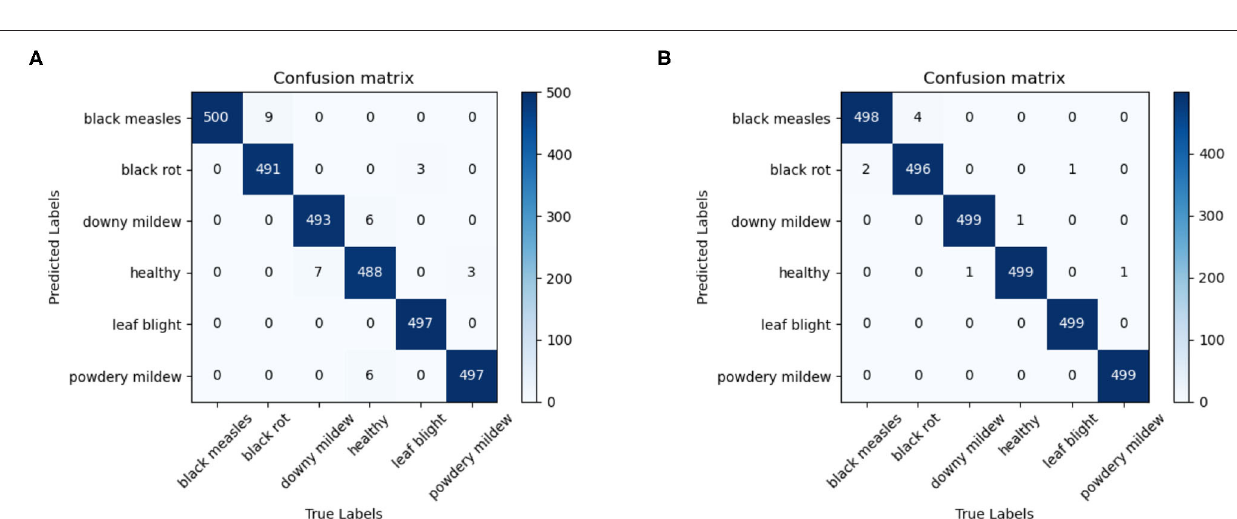
FIGURE 7 | Histogram of weights numerical distribution of the convolutional layer. (A) The numerical distribution iteration process of the first convolutional layer, (B) The numerical distribution iteration process of the last convolutional layer.